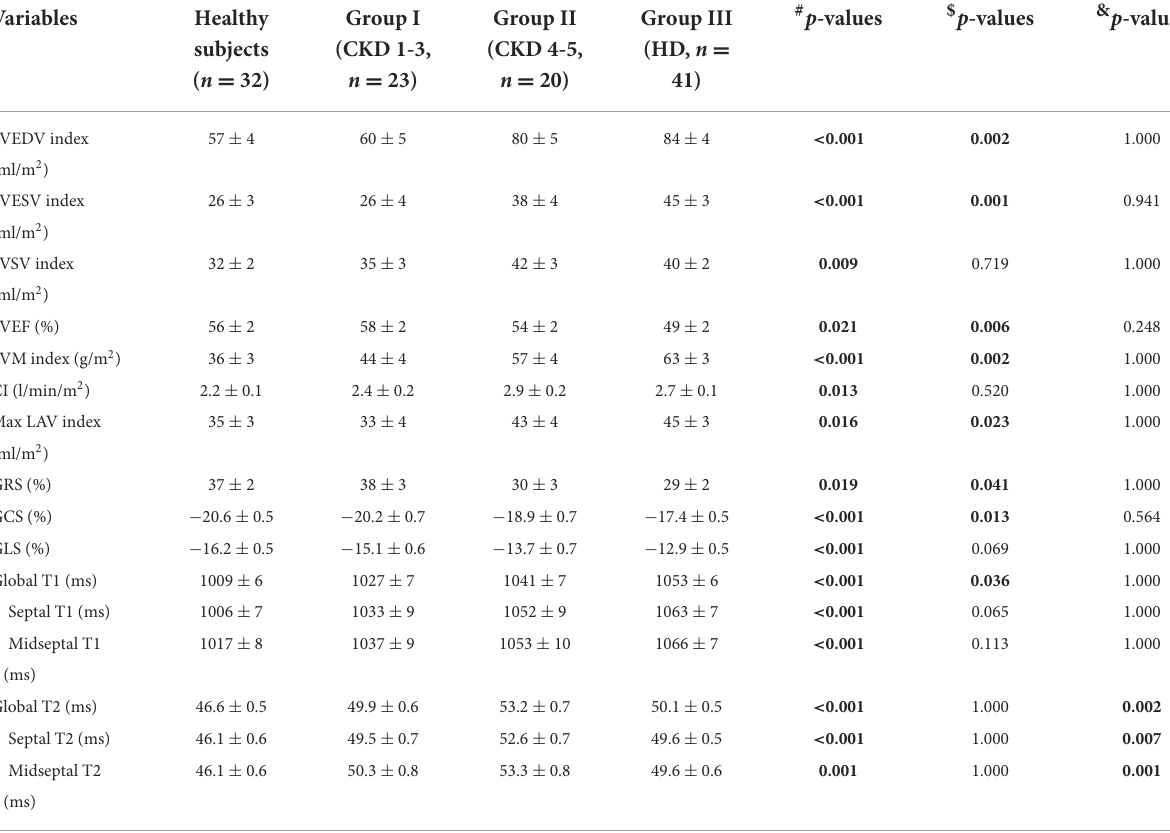
TABLE 5 Comparison of CMR characteristics between HD patients and each other groups after adjustments for age, BMI, and HR. Variables